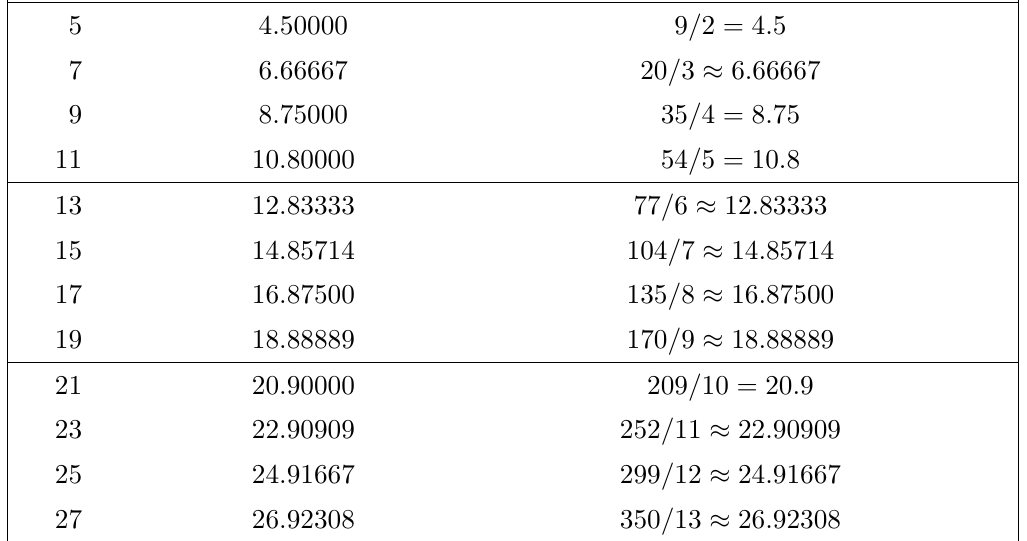
Table 1. Table of numerically calculated values of β compared with the scaling of the thermody- namic volume V ( D − 2) / ( D − 1) for large r + /‘ . Here we have computed numerically the values of β according to the method outlined in the text. The data is obtained by evaluating the complexity of formation between r + /‘ = 10 10 and r + /‘ = 10 20 and we have fixed (cid:15) = 10 − 10 , so we are con- sidering the situation very close to extremality. The numerical values agree with the scaling of the thermodynamic volume to at least five decimal places in all cases. By pushing the domain of r + /‘ to large values, the agreement becomes even better. Note that in all cases the scaling differs from the scaling of the entropy which behaves like ( r + /‘ ) D − 1 for large r + /‘ at fixed (cid:15) near